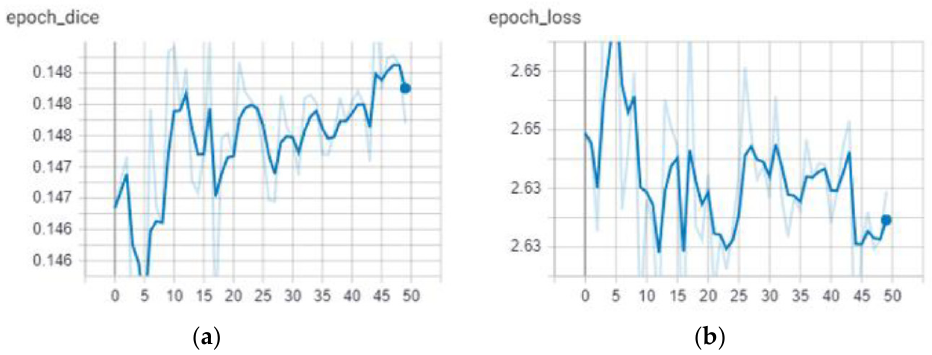
Figure 8. Dice score ( a ) and epoch loss ( b ) of the SGD optimizer for the epoch count of 50. FCN-8 has shown worse results compared to UNet. We had to run for 500